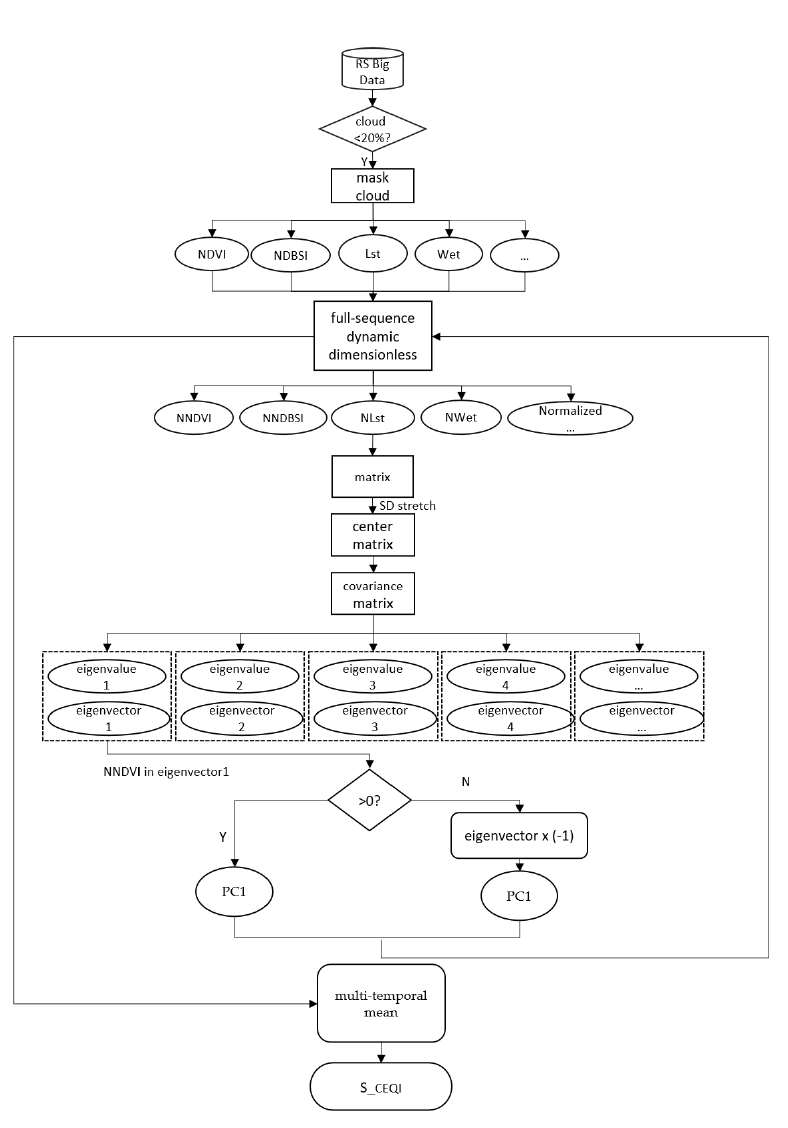
Figure 3. The flowchart of the S_CEQI .